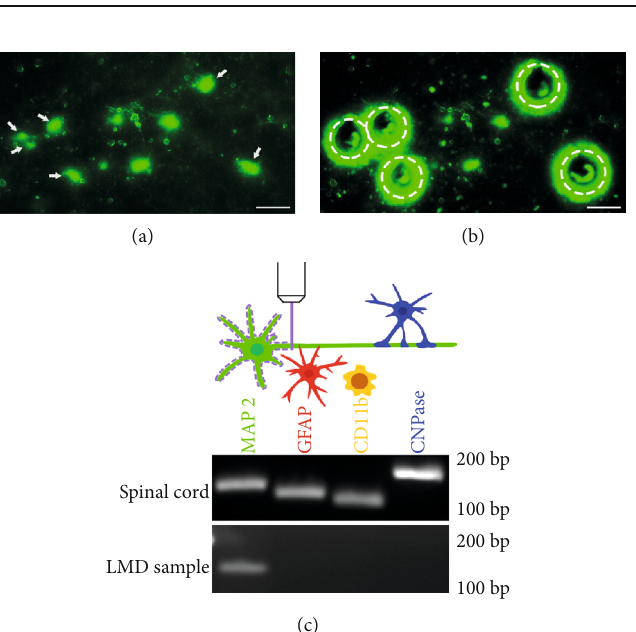
Figure 1: Single-cell laser capture microdissection (LMD) of A11 DA-ergic neurons. (a, b) Isolation of A11 neurons using LMD in fresh brain sections of hTH-eGFP transgenic rats. GFP-expressing A11 DA-ergic neurons (arrows) can be directly detected under a fl uorescent microscope (a) and captured by laser. Following successful isolation, empty circles are present where DA-ergic cells were captured from A11 nuclei (b). (c) Representative data shows high purity of neurons in LMD samples. The electrophoresis gel shows the presence of MAP2 (green, neuronal marker), GFAP (red, astrocytic marker), CD11b (yellow, microglia marker), and CNPase (blue, oligodendrocytic marker) in whole spinal cord tissue lysate. However, only MAP2 was present for LMD samples, indicating that a high purity of neurons was obtained when utilizing LMD to isolate A11 DA-ergic cells. Scale bars: 50 μ